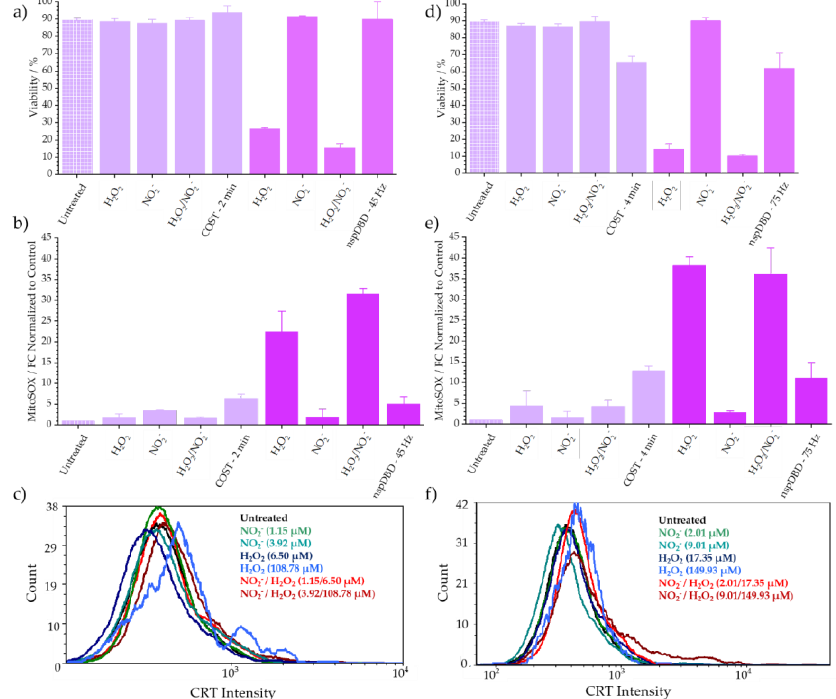
Figure 6. Exogenous addition of H 2 O 2 elicited cellular responses from Jurkat T lymphocytes at the two comparable conditions of 2 min/45 Hz ( a – c ) and 4 min/75 Hz ( d – f ). Mock treatment reduced viability and stimulated mitochondrial O 2 − production above the untreated control only at H 2 O 2 concentrations above 100 µM. ( d ) There were no changes in ecto-CRT responses to mock treatments. The mock treatment experiments were performed once in triplicate. The data represent the mean and standard deviation.